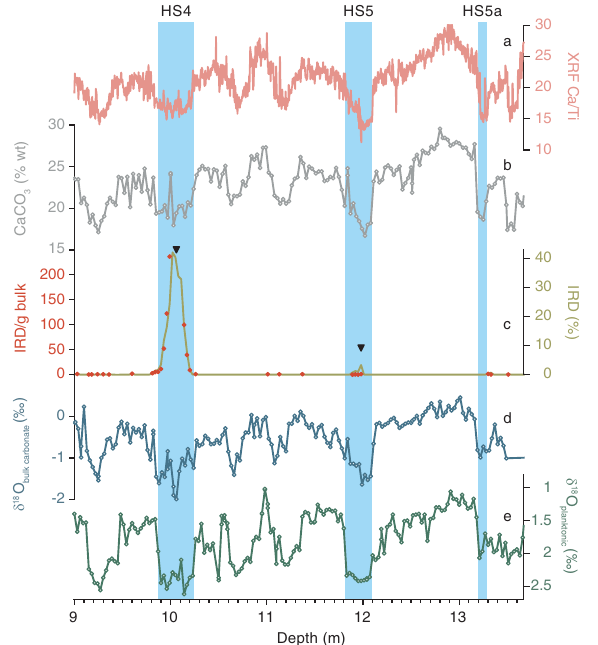
Fig. 2 MD01-2444 MIS 3 records plotted against depth (9 – 13.67 m). a XRF Ca/Ti record 35 . b Weight percent CaCO 3 (ref. 35 ). c IRD abundance: IRD grains per gram (red) and IRD percent [(IRD grains/(IRD grains + planktonic foraminifera) × 100)] (ref. 33 ). d Bulk carbonate δ 18 O (ref. 35 ). e Planktonic ( G. bulloides ) foraminiferal δ 18 O (ref. 33 ). Vertical bars denote HS4, HS5 and HS5a. Triangles denote depths from which detrital carbonate grains were taken for stable isotope measurements (See Fig. 3). (Fig. 1f and e) reproduce the typical succession of stadials and interstadials from DO15 to DO7. Most extreme changes were associated with HS5 and HS4, leading to ~4 °C decreases in SST and ~1 ‰ increases in planktonic δ 18 O. Benthic foraminiferal δ 18 O values (Fig. 1g) decrease gradually during stadials, with greater reductions (~0.5 ‰ ) during HS5 and HS4. A distinct peak in IRD abundance occurs within HS4 and a much smaller peak in HS5; most commonly found lithics are quartz, with presence of some detrital carbonate grains (Figs. 1d and 2c). The bulk car- bonate δ 18 O record (Fig. 2d), a sensitive proxy for identifying Heinrich layers, shows that the IRD peaks at ~10 and ~12 m in MD01-2444 are marked by the lowest values, in line with low δ 18 O values of dolomitic limestone in northeastern Canada 36 . Stable isotope analyses on single detrital carbonate grains taken from these IRD peaks reveal that their δ 18 O and δ 13 C composi- tion is consistent with an origin from Hudson Strait 36 (Fig. 3).